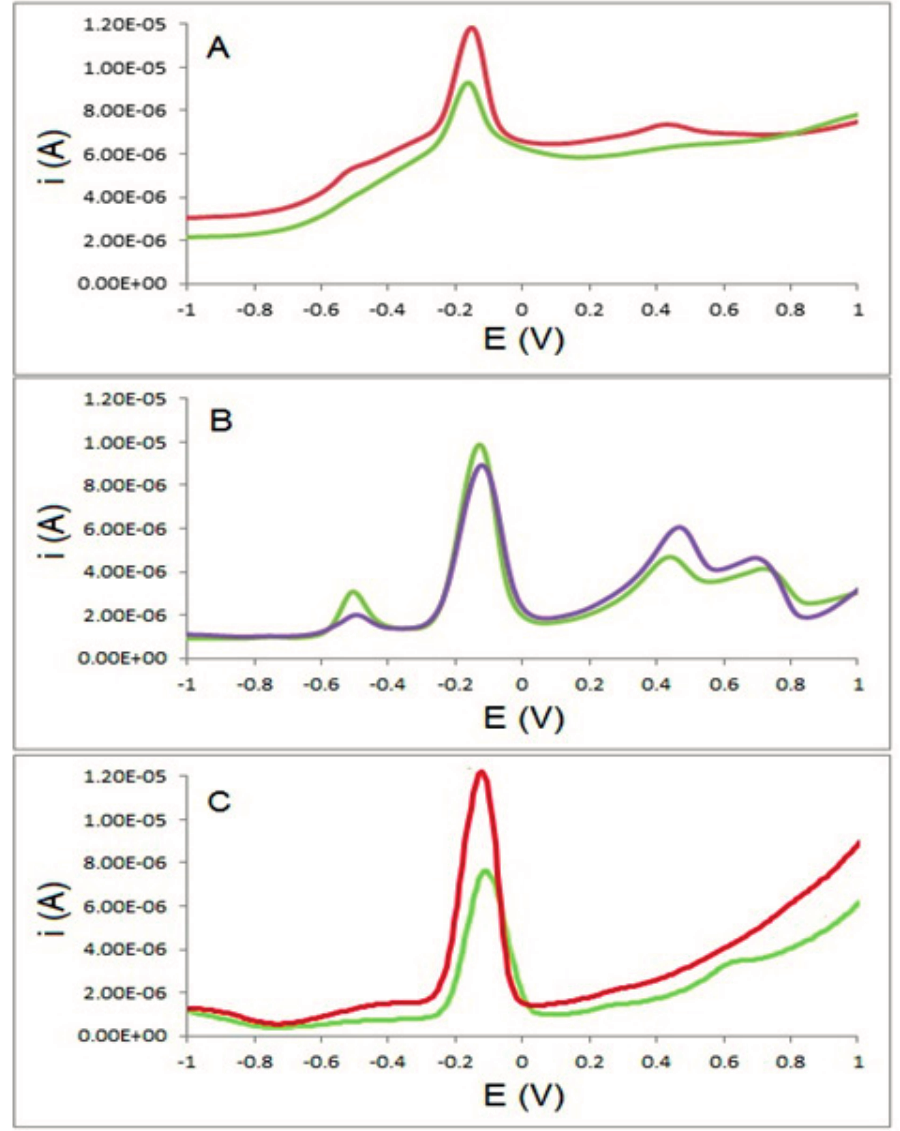
Figure 8. Differential pulse voltammograms of ( A ) TATP at concentrations of 1108 and 2216 µg·L − 1 (green and red colors, respectively) and using a molecular imprinted polymer modified electrode and ( B ) TATP at concentrations of 44.42 and 88.85 mg·L − 1 (blue and green colors, respectively) using a bare glassy carbon electrode. For (A) and (B) the solutions contained 1 mg·L − 1 of each of PETN, TNT, RDX, and HMX with 0.025 mol·L − 1 LiClO 4 as supporting electrolyte. For ( C ) the solution contained TATP at concentrations of 2216 and 4432 µg·L − 1 (green and red colors, respectively) and 0.025 mol·L − 1 LiClO 4 using a molecular imprinted